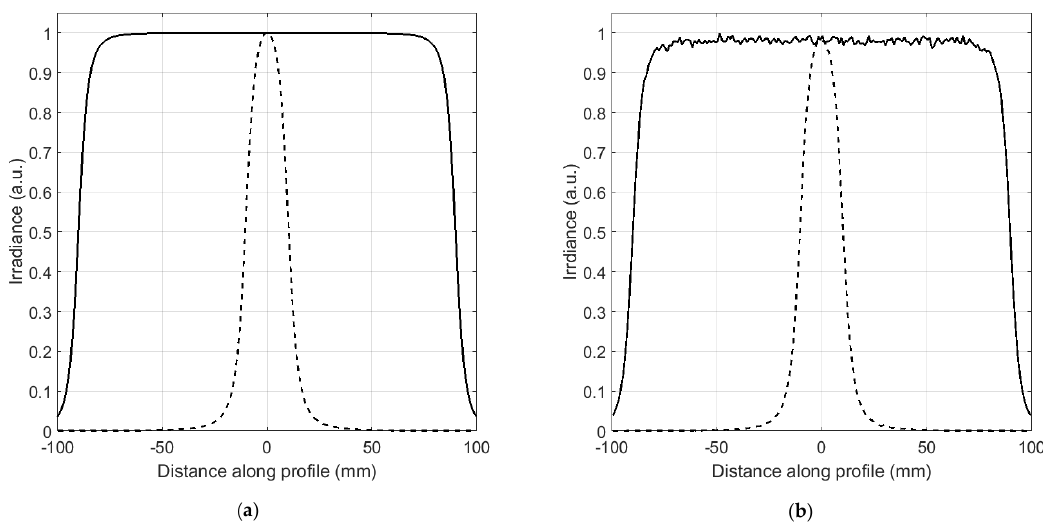
Figure 3. Irradiance map and central irradiance profile of rectangular source of 20 × 180 mm 2 ; detector of 200 × 200 mm 2 ; z detector distance 5 mm. ( a ) Flowline computation ( b ) Raytrace computation